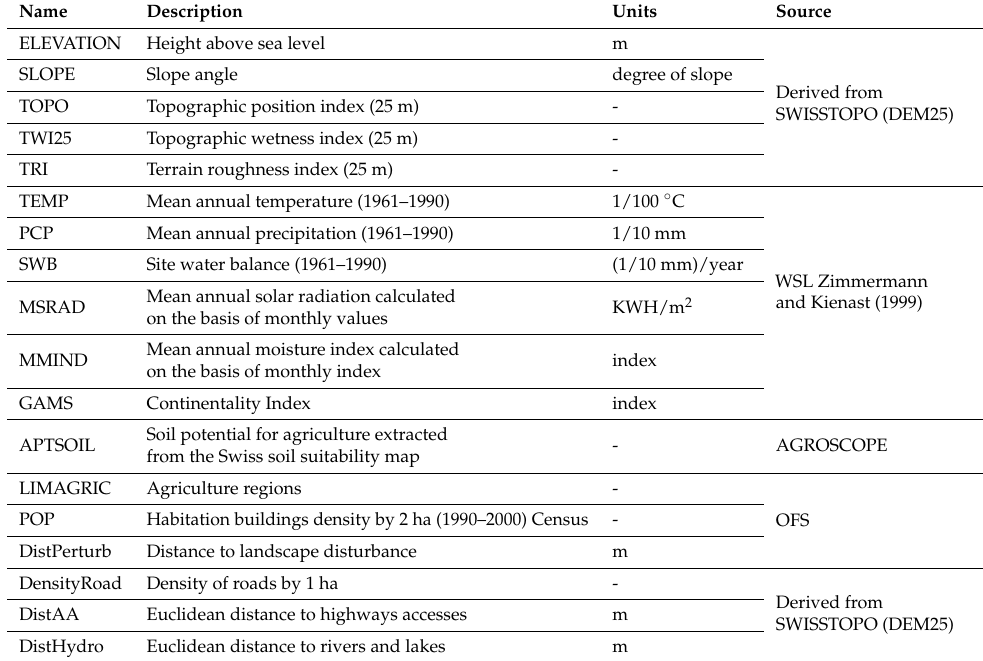
Table 2. Drivers of land use